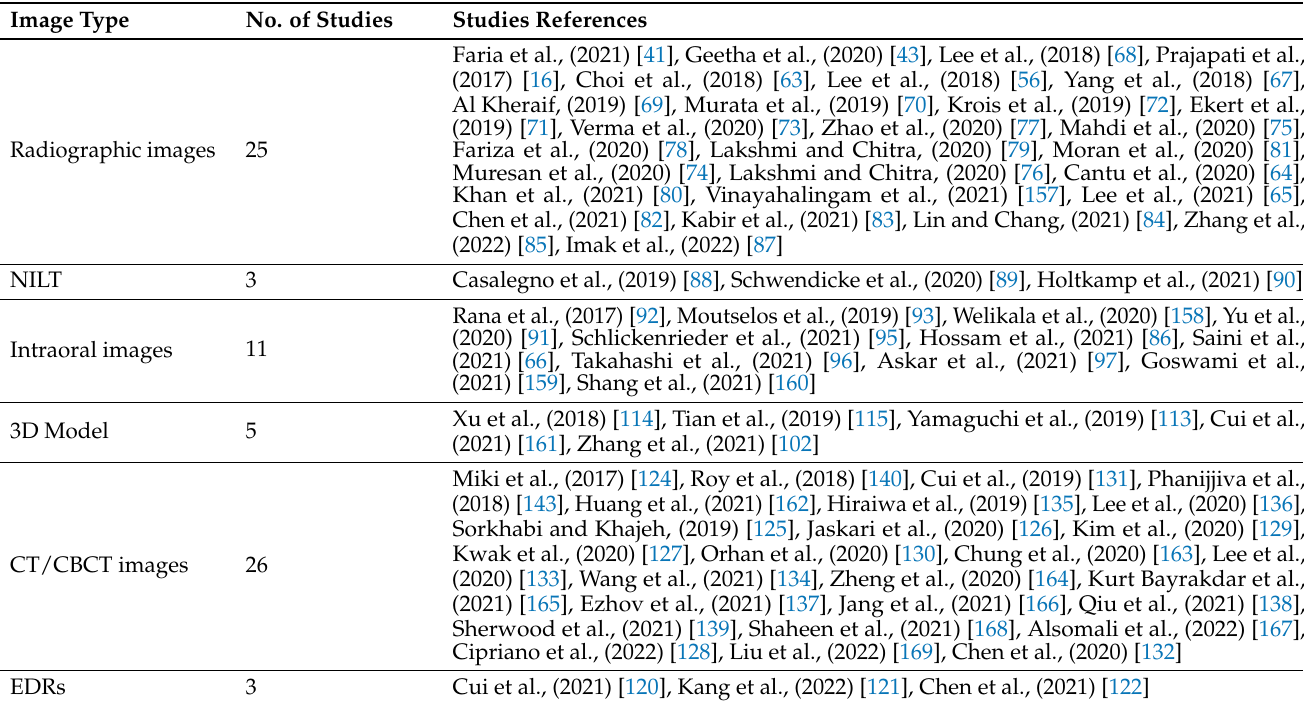
Table 11. Types of images to evaluate DL techniques.